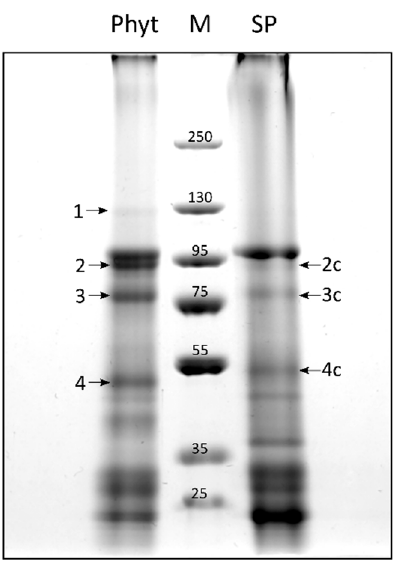
Figure 5. Longer incubation of leaf samples with biotin reveals new candidate phytaspase interactors. After prolonged (16 h) incubation of leaf samples with 200 µ M biotin, proteins were extracted from the intracellular fractions of Nt Phyt-TurboID- or SP-TurboID-producing leaves (Phyt and SP, respectively; obtained from equal 5 g amounts of leaf material) in the presence of 0.5% dodecyl maltoside. Biotinylated proteins that precipitated within the 50–70% interval of ammonium sulphate saturation were further affinity-purified using streptavidin magnetic beads. The eluted protein samples were concentrated by acetone precipitation, dissolved in 45 µ L of SDS-containing buffer and analysed by SDS electrophoresis in a 6–16% gradient polyacrylamide gel. Proteins were visualized after Coomassie Blue staining. M, molecular weights of the protein markers. Arrows with numbers indicate the bands chosen for subsequent protein identification.